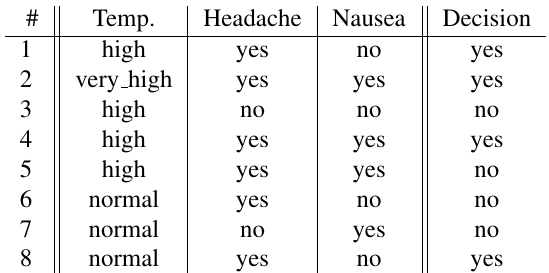
Table 1. Patient’s Decision